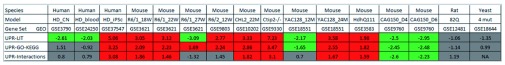
Differential regulation of UPR gene sets detected in HD expression data.For each of the compiled UPR genes sets, the normalized enrichment scores (NES) produced by GSEA are shown for different comparisons of HD-associated expression with controls. Positive scores indicate a tendency towards upregulation; negatives scores indicate a tendency towards downregulation of genes in the UPR sets. Comparisons that showed significant upregulation of UPR gene sets (
fdr ≤ 0.05 and NES ≥ +1.4) are highlighted by red background, while significant downregulation (
fdr ≤ 0.05 and NES ≤ +1.4) by green background.